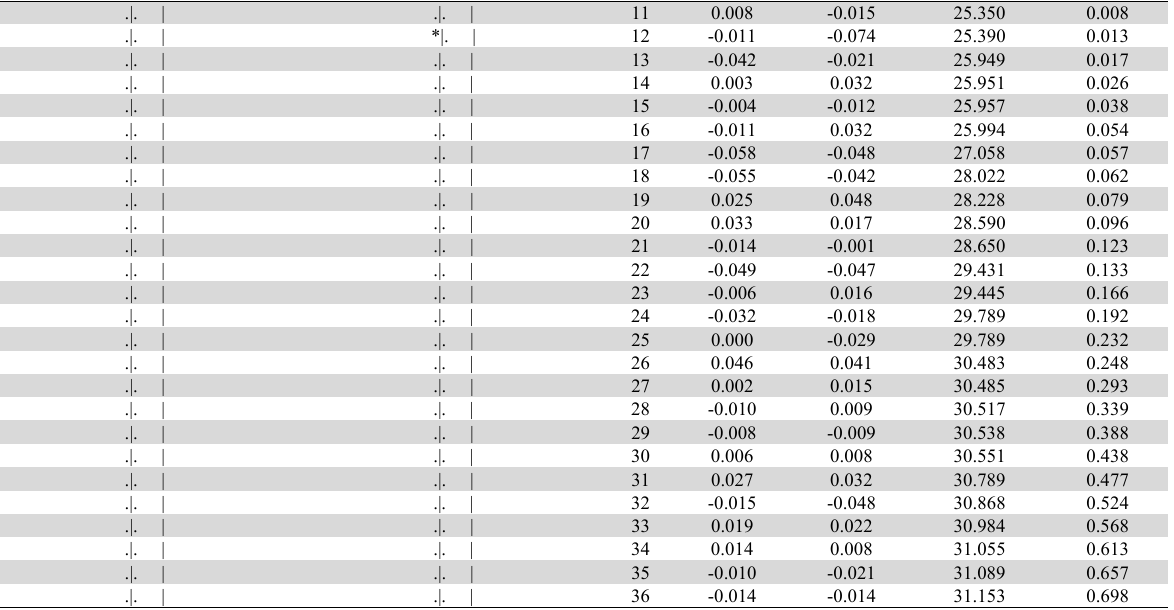
Exhibit the Pre-Estimation …. (Continued) .|. |